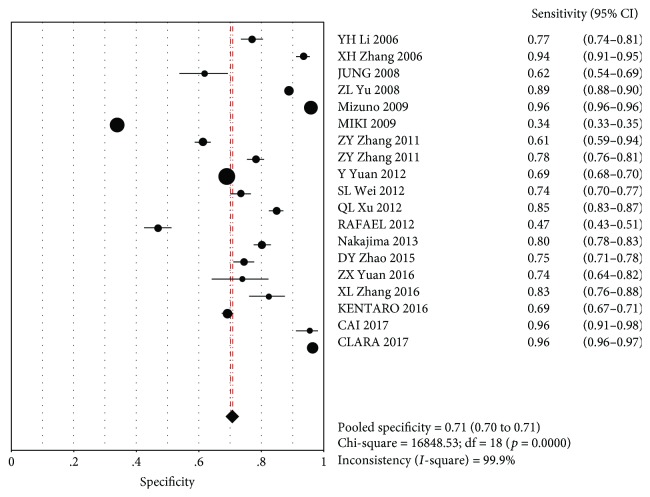
Consolidation specificity.